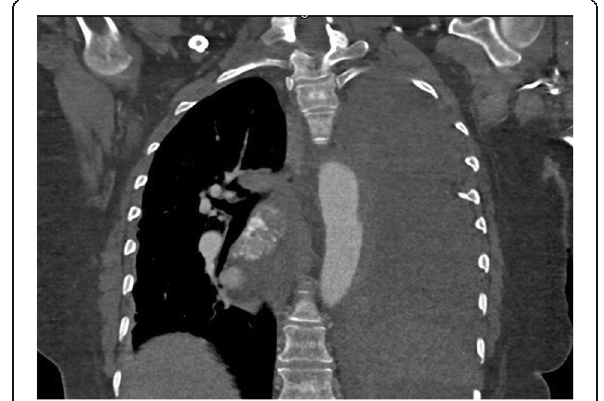
Fig. 3 Pre-TEVAR CTA (coronal view) showing focal intimal irregularity in the distal aortic arch. No evidence of active extravasation